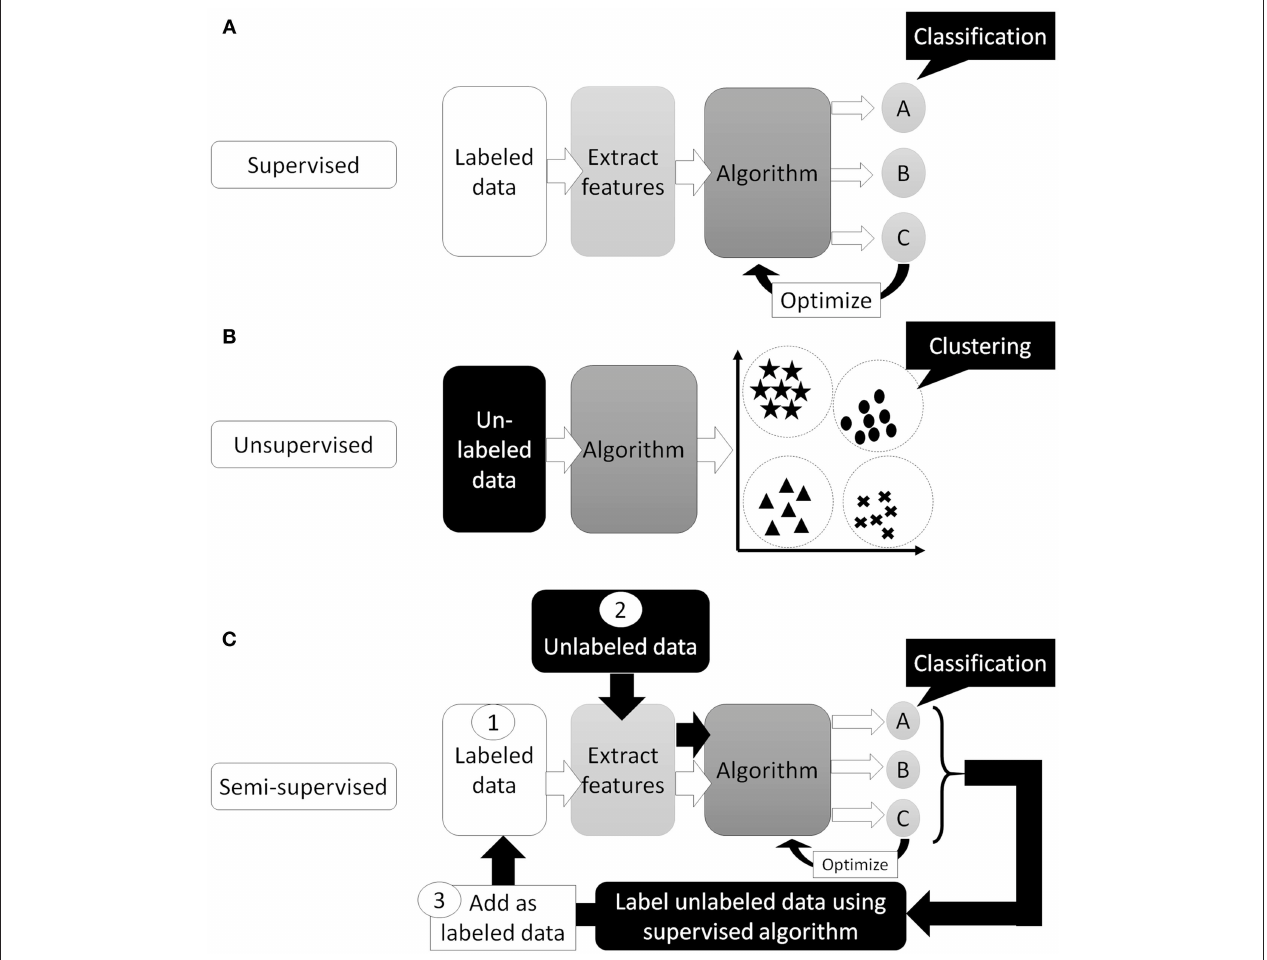
FIGURE 1 | Supervised or unsupervised training. (A) Supervised training which can predict classification or regression of the input data. (B) Unsupervised training which can cluster the data. (C) Semi-supervised training. First, train the algorithm by small number of labeled data. Then, use trained algorithm to “label” unlabeled data. Next, re-train algorithm using newly labeled data and originally labeled data. Finally, algorithm trained with all data and can predict classification or regression of the input